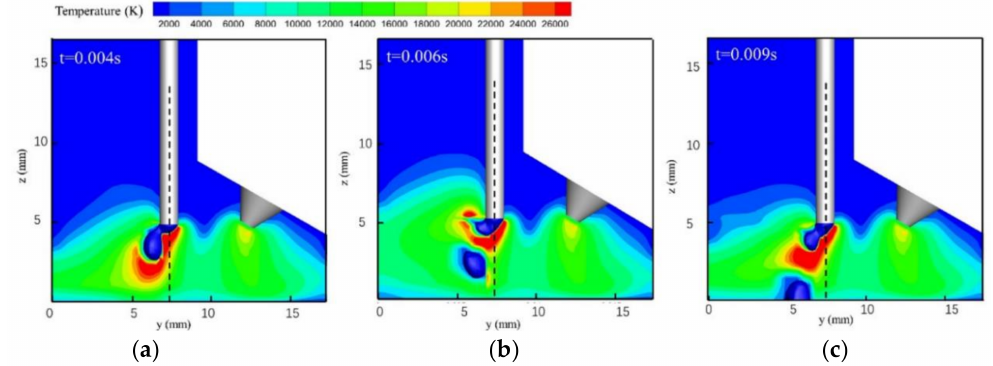
Figure 3. TIG-MIG arc temperature distribution: ( a ) t = 0.004 s; ( b ) t = 0.006 s; ( c ) t = 0.009 s.